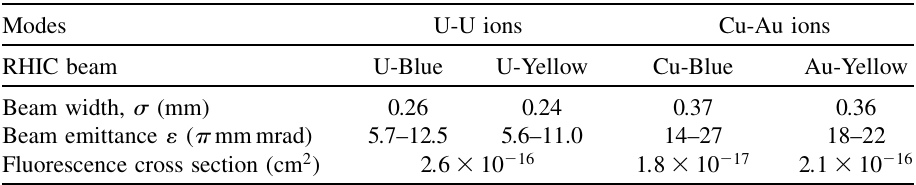
TABLE II. Summary of RGFM